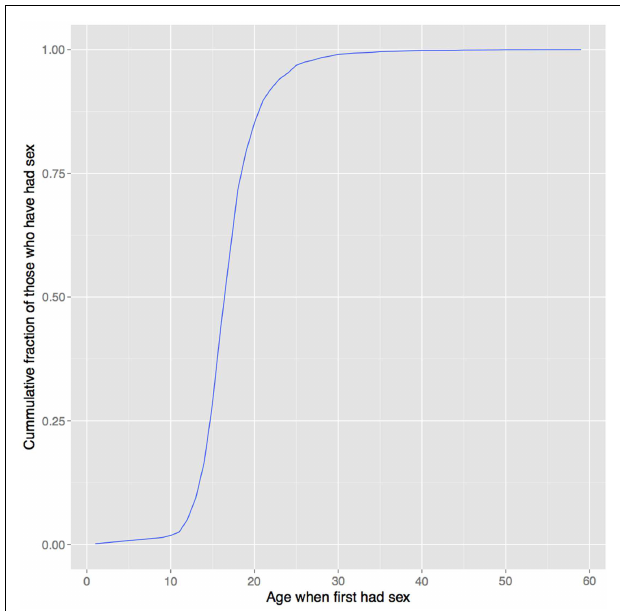
FIGURE 6 |Age of first sexual intercourse in NHANES data .This cumulative distribution closely resembles that of age of first substance use seen in Figure 1 . Data from Ref. (123).